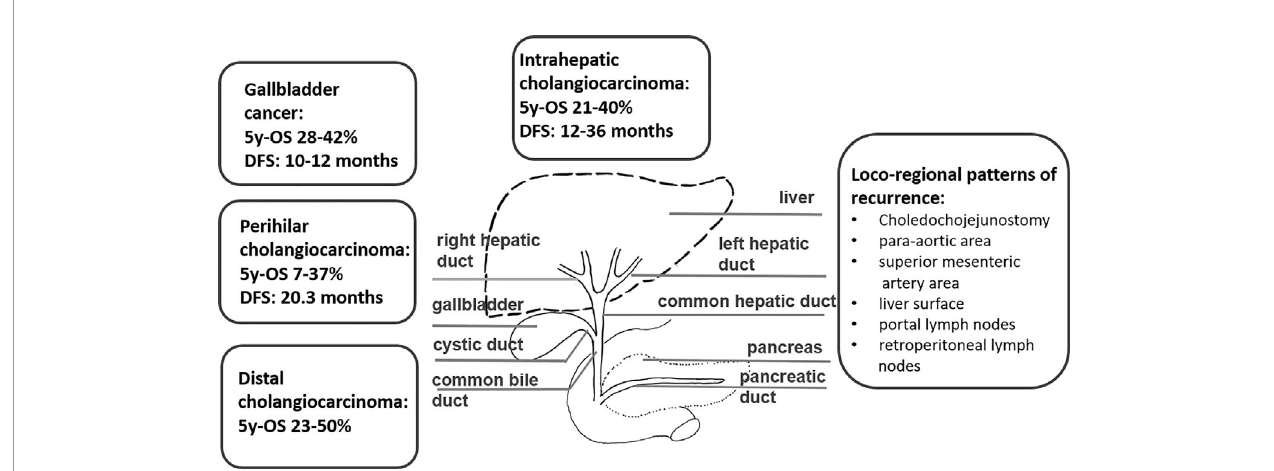
FIGURE 1 | The classi fi cation of biliary tract cancers, overall survival and patterns of